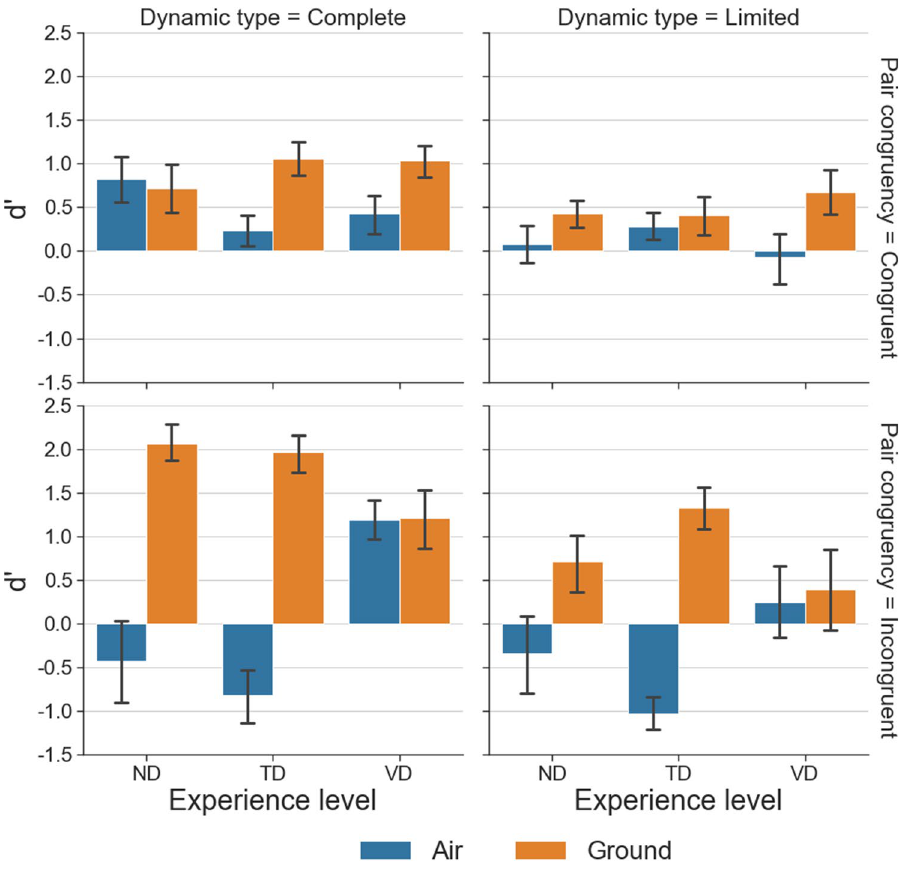
Figure 2. Mean d’ as a function of experience level ( x -axis; ND: Non-Dancers, TD: Typical Dancers; VD: Vertical Dancers), dynamic type (column), pair congruency (row), and recording type